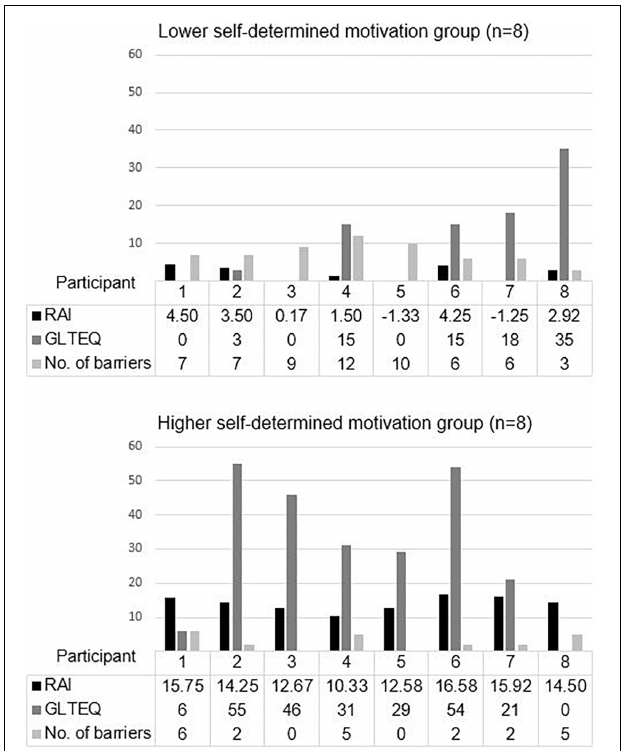
FIGURE 1 | Number of barriers to PA/exercise, self-determined motivation, and a volume of PA/exercise in lower and higher self-determined motivation groups. Relative Autonomy Index; Godin Leisure-Time Exercise Questionnaire; No. of PA/exercise barriers was calculated based on the total number of themes and